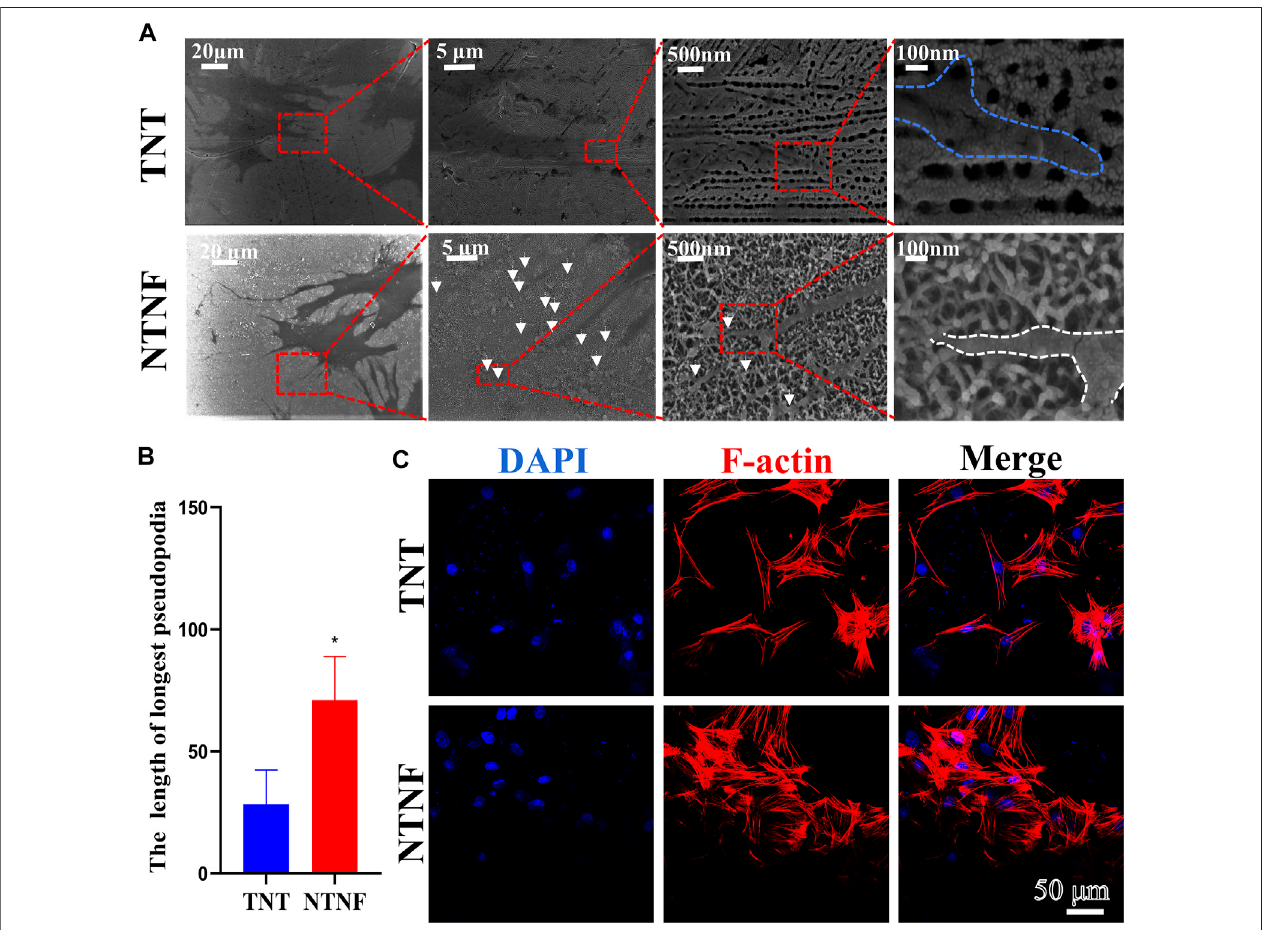
FIGURE6|(A) SEMimagesofrBMSCsattachedonthesurfaceofTNTandNTNFfor24 h.WhitearrowsrefertothetentaclesofrBMSC. (B) Lengthof fi lamentous pseudopodia of the rBMSCs on the TNT and NTNF samples surface. (C) CLSM images of rBMSCs morphology and attachment after culturing on TNT and NTNF for 24 h by immuno fl uorescence staining [nuclei (blue), f-actin